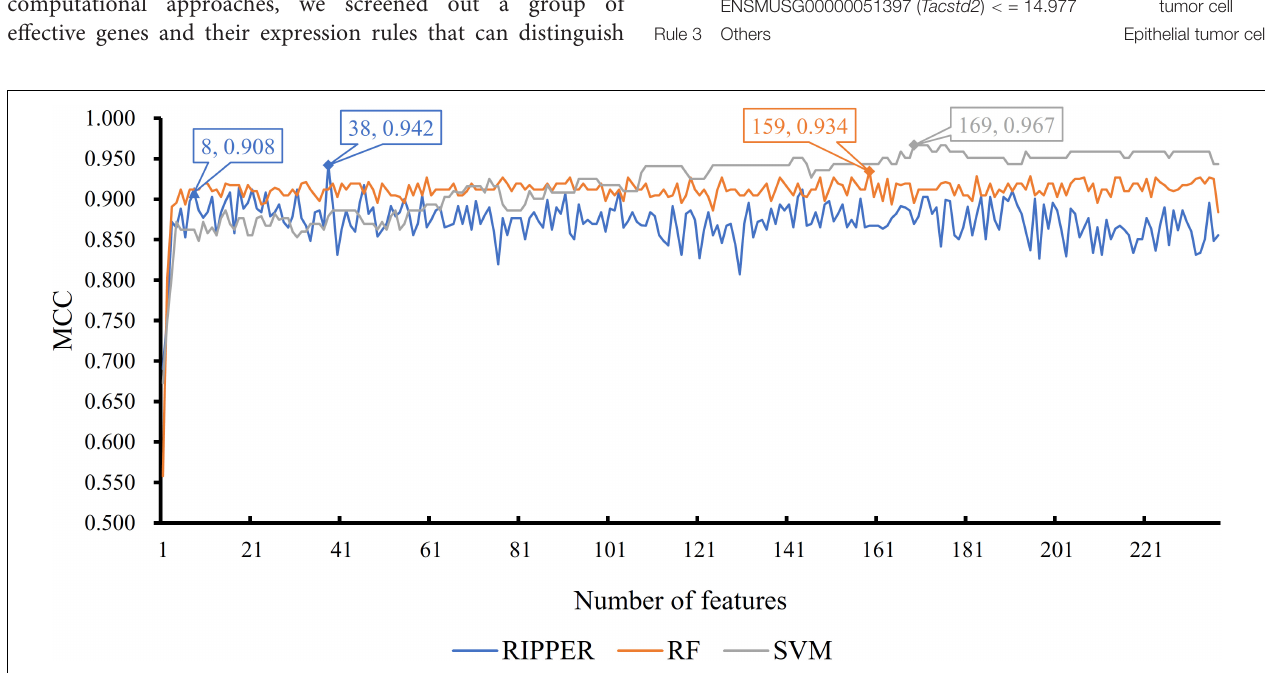
Frontiers in Genetics |